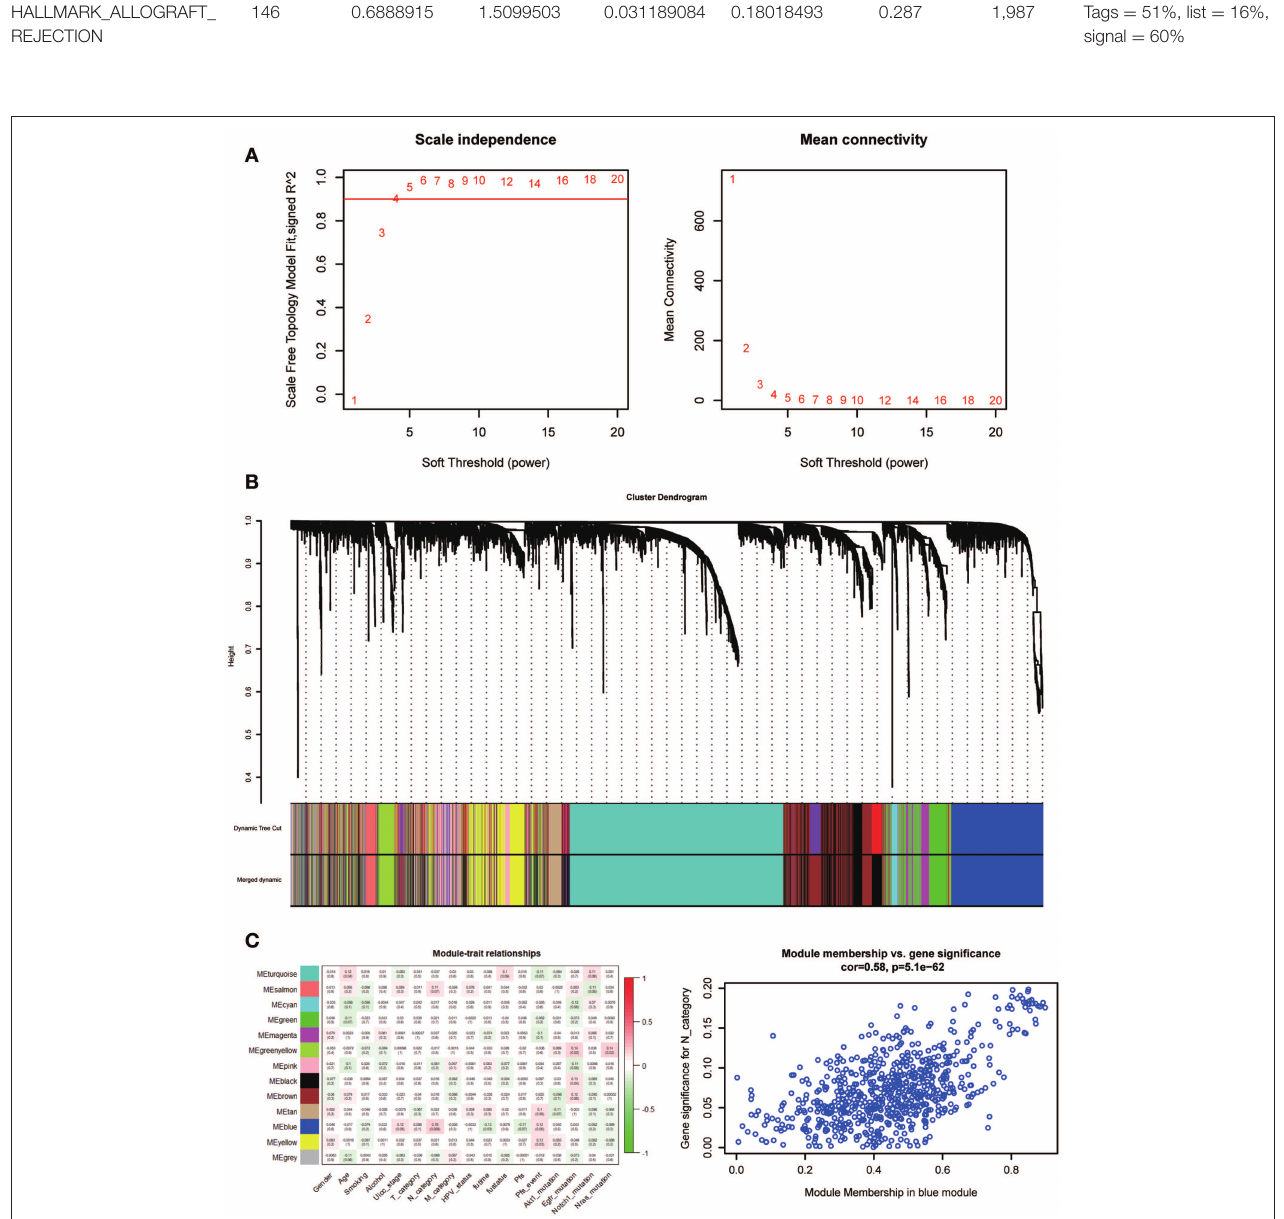
FIGURE 5 | Determination of soft-thresholding power in WGCNA. (A) Analysis of the scale-free fit index for various soft-thresholding powers ( β ) and analysis of the mean connectivity for various soft-thresholding powers. (B) Dendrogram of all differentially expressed genes clustered based on a dissimilarity measure. (C) Heatmap of the correlation between module eigengenes and clinical traits of HNSC. Scatter plot for correlation between gene module membership in the blue module and gene significance.